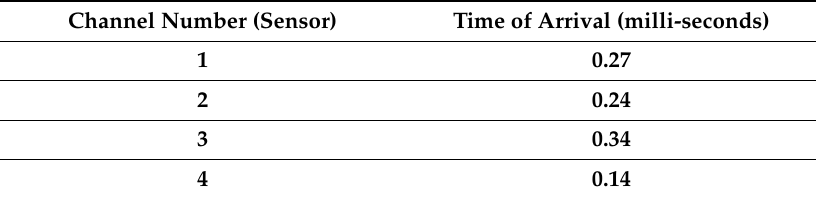
Table 4. Time of arrival of the AE signals for four channels (sensors).